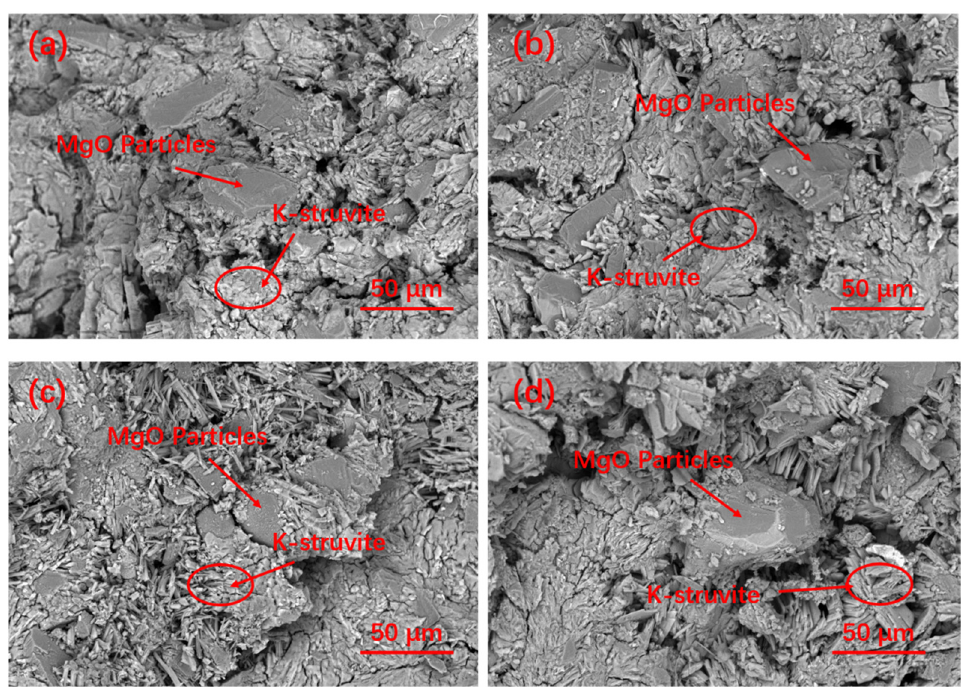
Figure 11. SEM pictures of MPC with various modi fi ed MgO cured at − 5 °C for 28 d: ( a ) G0; ( b ) G5; ( c ) G7.5; ( d ) G10.